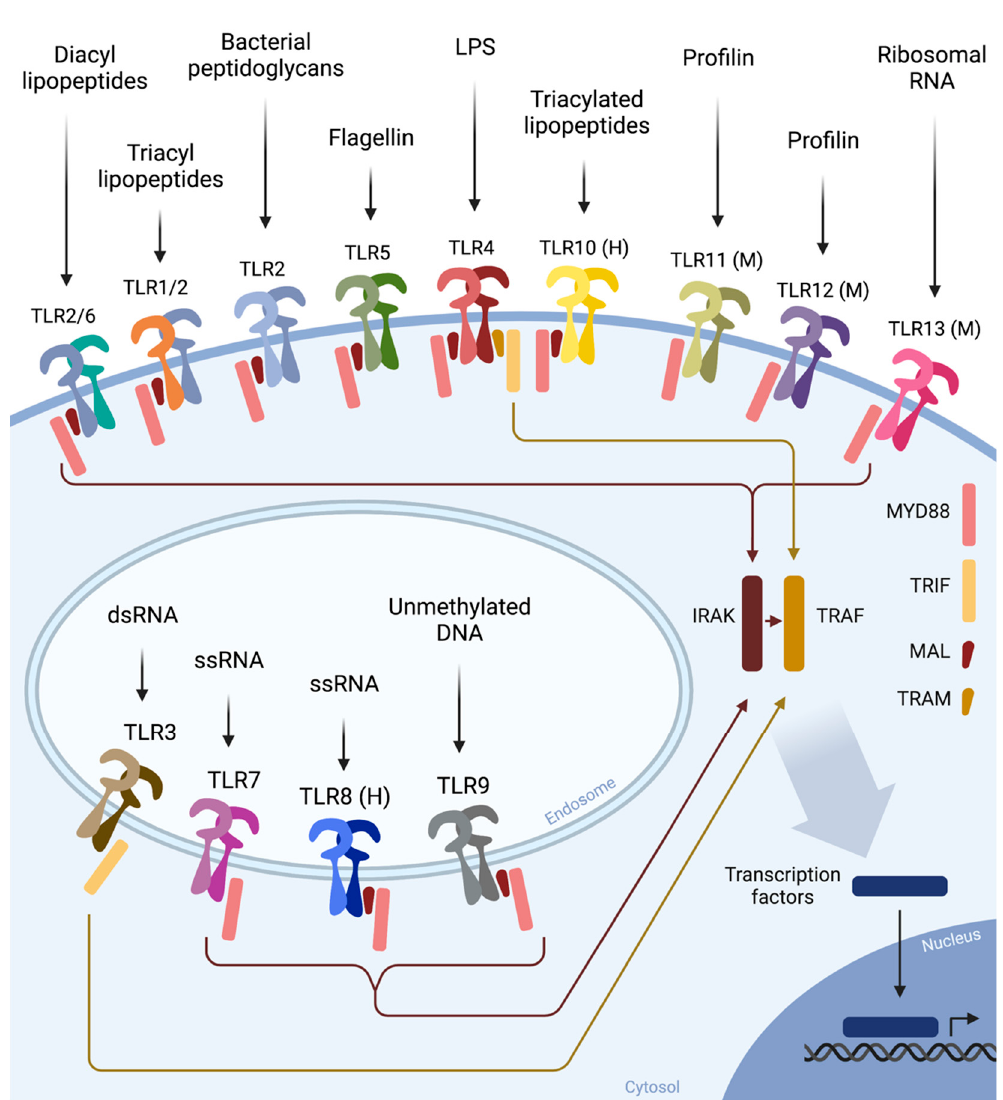
Figure 3. Illustration of all known TLRs and their ligands and adaptors, including those exclusive to mice (M) and humans (H).